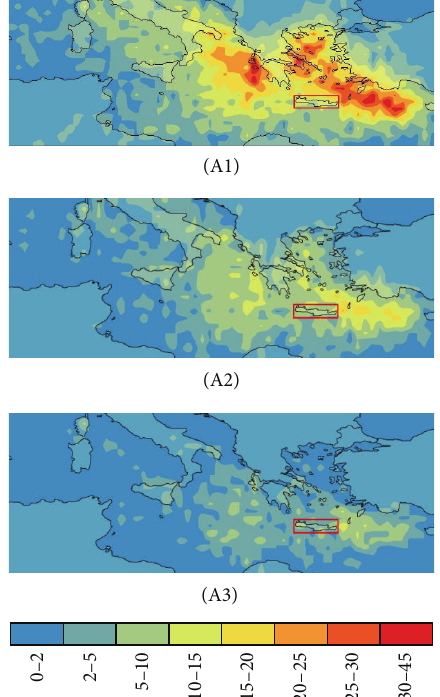
Figure 3: Number of “affecting” and “hitting” cyclones for the time period1979–2011for (1) light, (2) medium,and (3)